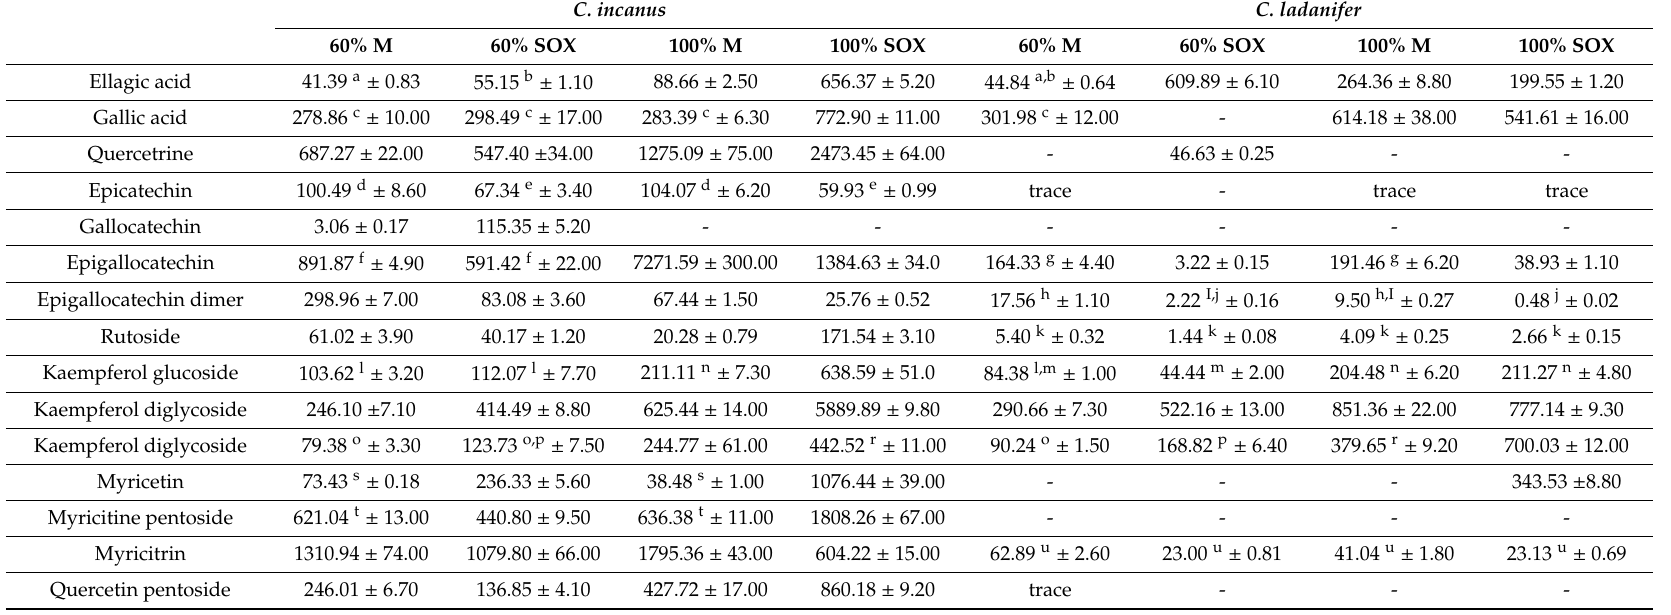
Table 4. Quantitative LC / MS analysis of C. incanus and C. ladanifer